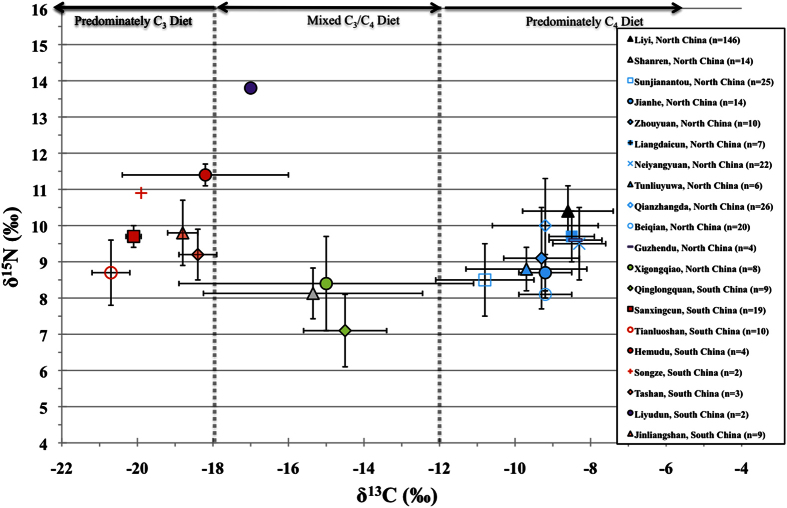
Human δ13C and δ15N values (mean ± sd) from the Liyi and Shanren sites, and the previous published isotopic results from pre-Qin and Qin populations in north and south China.